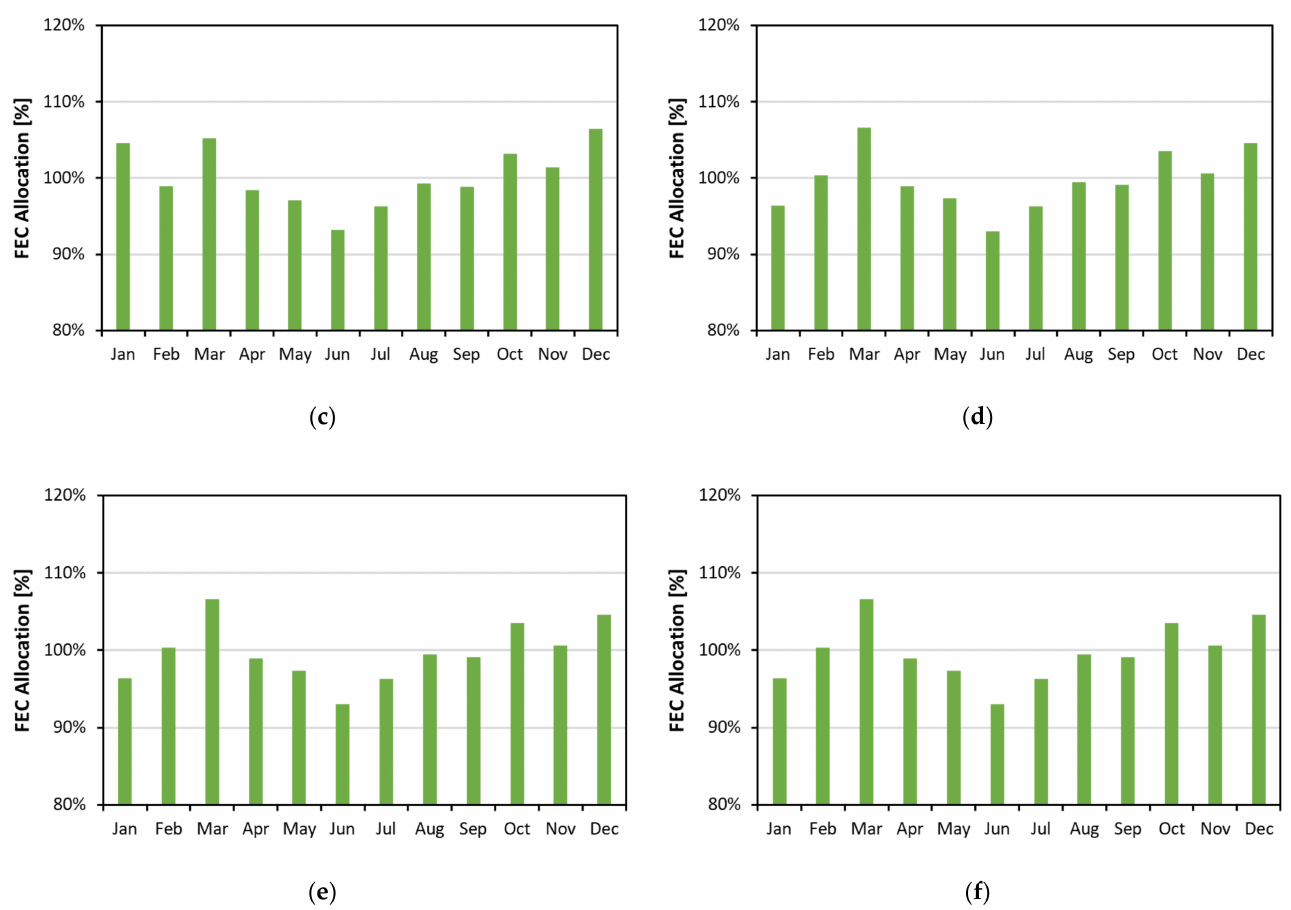
Figure 7. ERM default allocation factor for the years: ( a ) 2014; ( b ) 2015; ( c ) 2016; ( d ) 2017; ( e ) 2018; and ( f ) 2019.